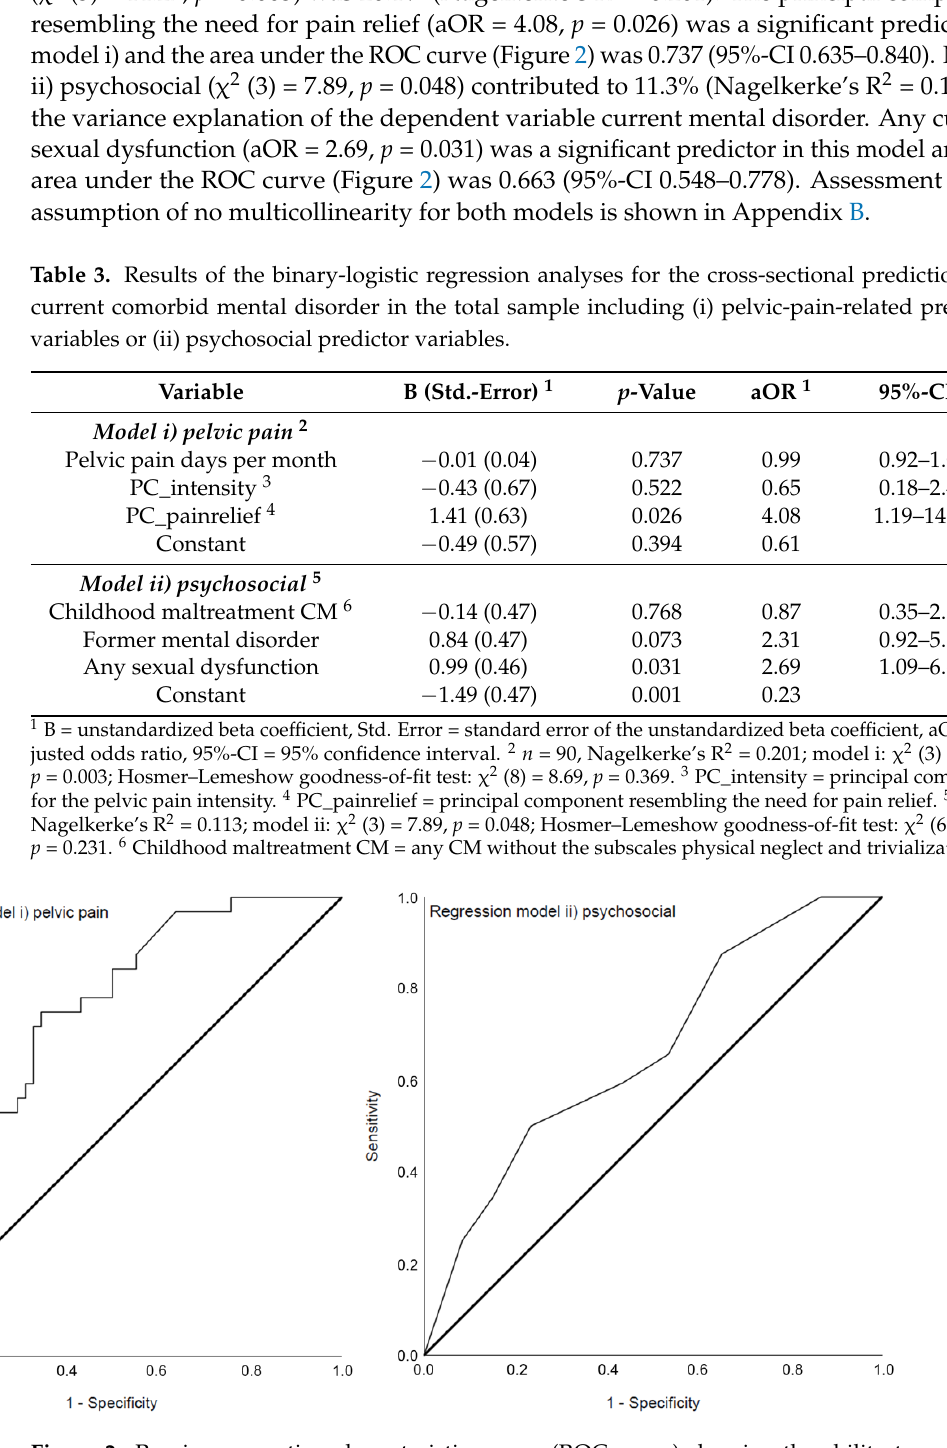
Figure 2. Receiver operating characteristics curve (ROC curve) showing the ability to predict a current mental disorder of the models i) pelvic pain with an area under the curve of 0.737 (95%-CI 0.635 – 0.840) and ii) psychosocial with an area under the curve of 0.663 (95%-CI 0.548 – 0.778).